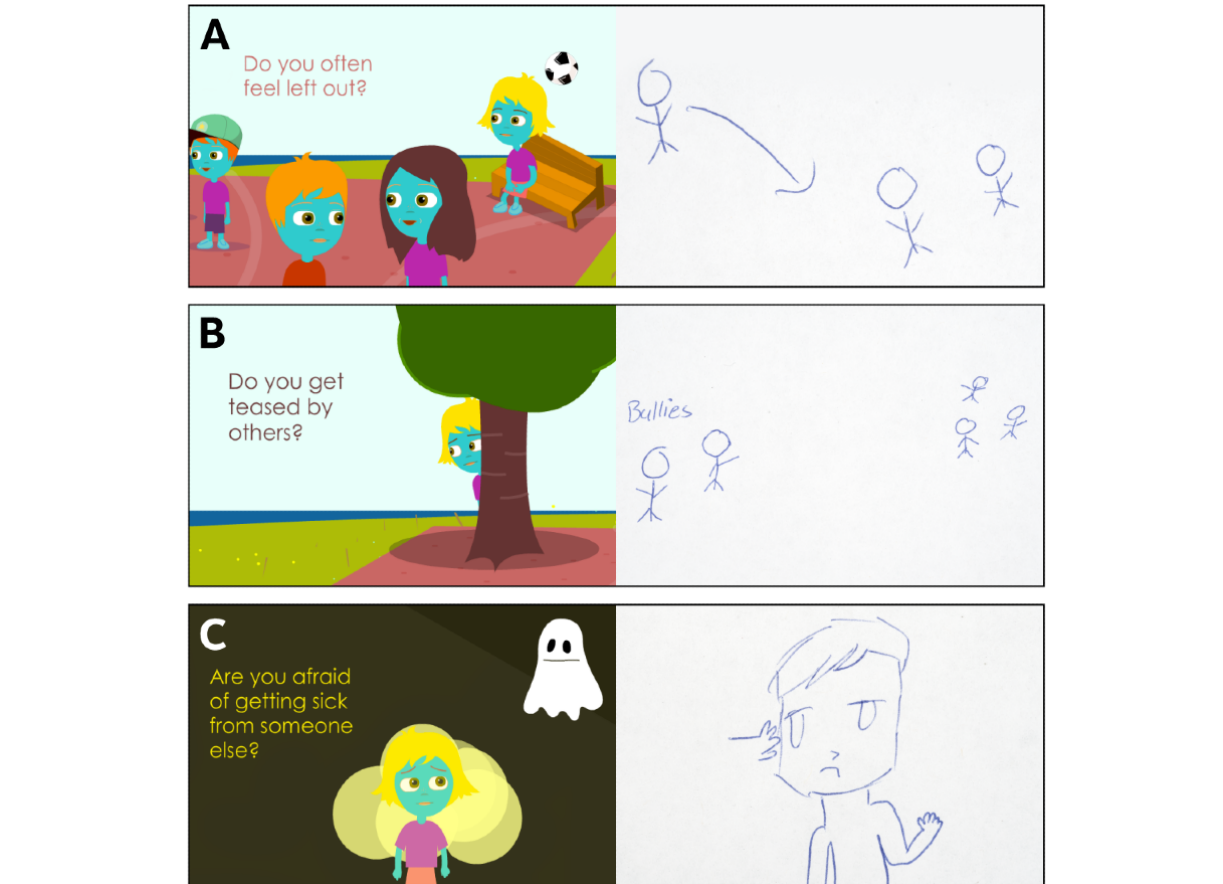
Figure 3. Suggested modifications to symptoms and the corresponding vignettes. A. “Do you ever feel left out?” changed from “Do you often feel left out?” Participant #5, 10 years old: “Instead of showing someone sitting on a bench, show a person walking up to a group of friends and when that person tries to talk to them, they just go somewhere else. That makes you feel left out...” B. “Do others ever bully you?” changed from “Do you get teased by others?” Participant #5, 10 years old: “Instead of someone hiding behind a tree, there should be bullies teasing and pointing.” C. “Are you afraid of getting hurt by someone?” changed from “Are you afraid of getting sick from someone else?” Participant #5, 10 years old: “Show a person sitting down who is being